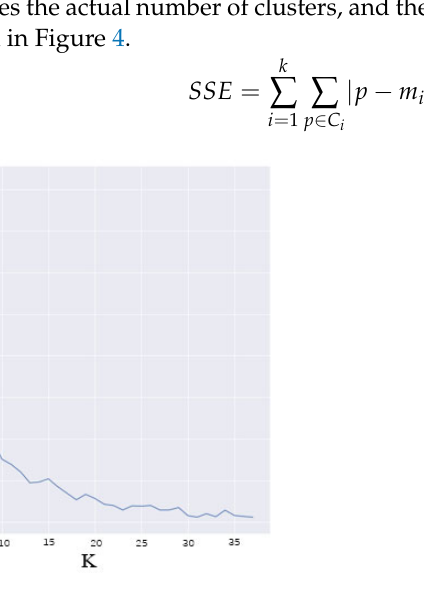
Figure 4. The determined values of K.